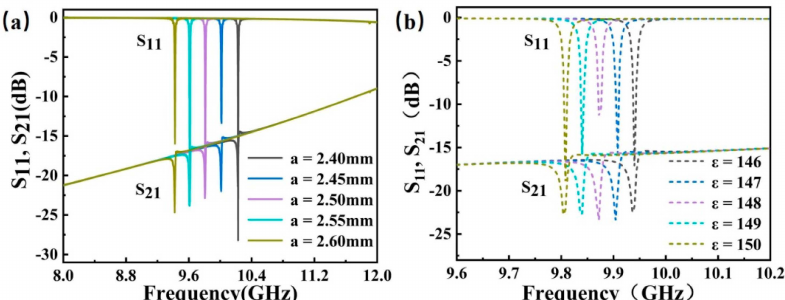
Figure 5. ( a ) simulated S11 and S21 spectra when a = 2.40 − 2.60 mm, ε = 150; and ( b ) simulated S11 and S21 spectra when a = 2.50 mm, ε = 146 − 150.